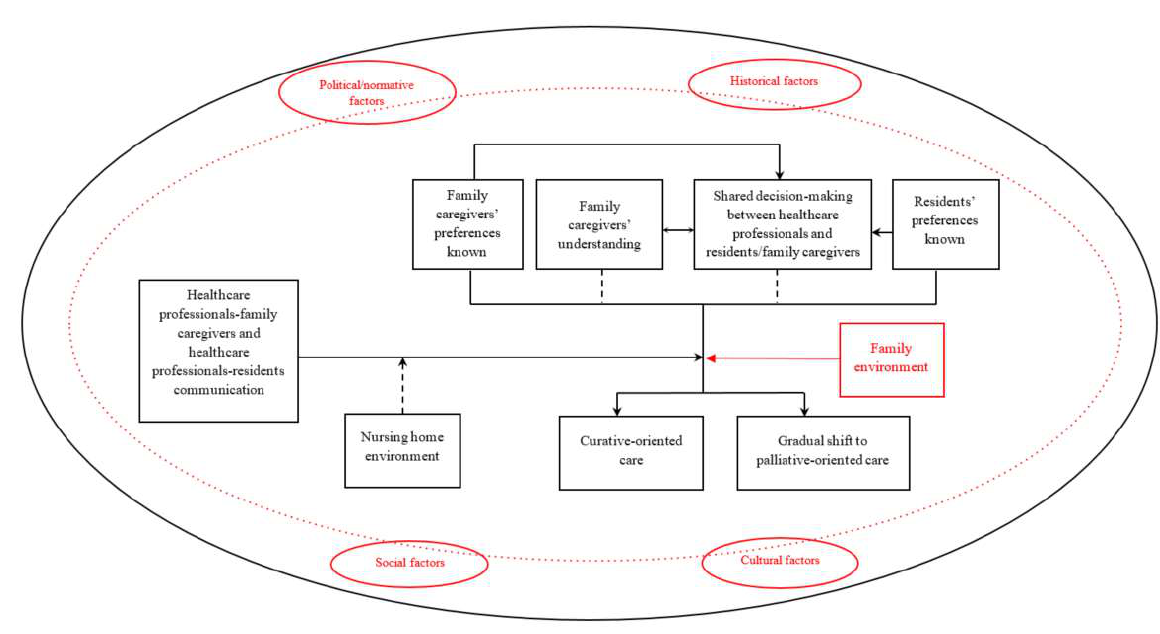
Figure 1. Existing End-of-Life Communication Theory and Refined Situation-Specific Theory of End-of-Life Communication in Nursing Homes. Note . Changes to the existing end-of-life communication theory [21] are shown in red. The nursing home environment may influence the timing and quality of end-of-life communication that in turn impacts end-of-life care by affecting (a) the family caregivers’ understanding; (b) the shared decision-making between healthcare professionals and resident/family caregivers; and (c) the knowledge of residents’ and (d) family caregivers’ preferences for end-of-life care. Family understanding and shared decision-making appear not to be essential for the provision of palliative-oriented care, although they have a positive role. Political/normative, historical, social, and cultural factors influence the communication process.